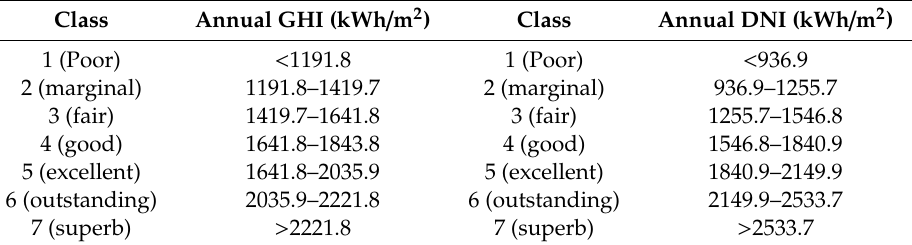
Table 9. GHI and DNI